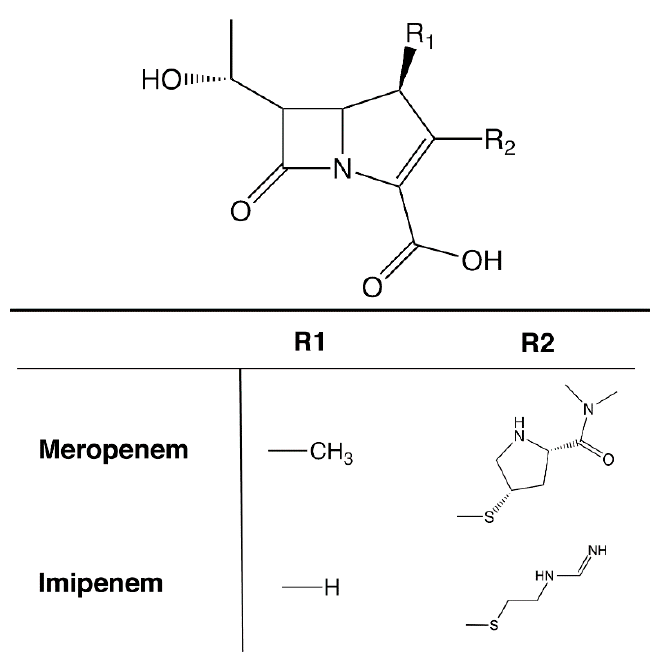
Figure 1. Structure of carbapenems. Generic chemical structure of carbapenems. The R1 and R2 groups for imipenem and meropenem, the most used in the clinics, are shown.